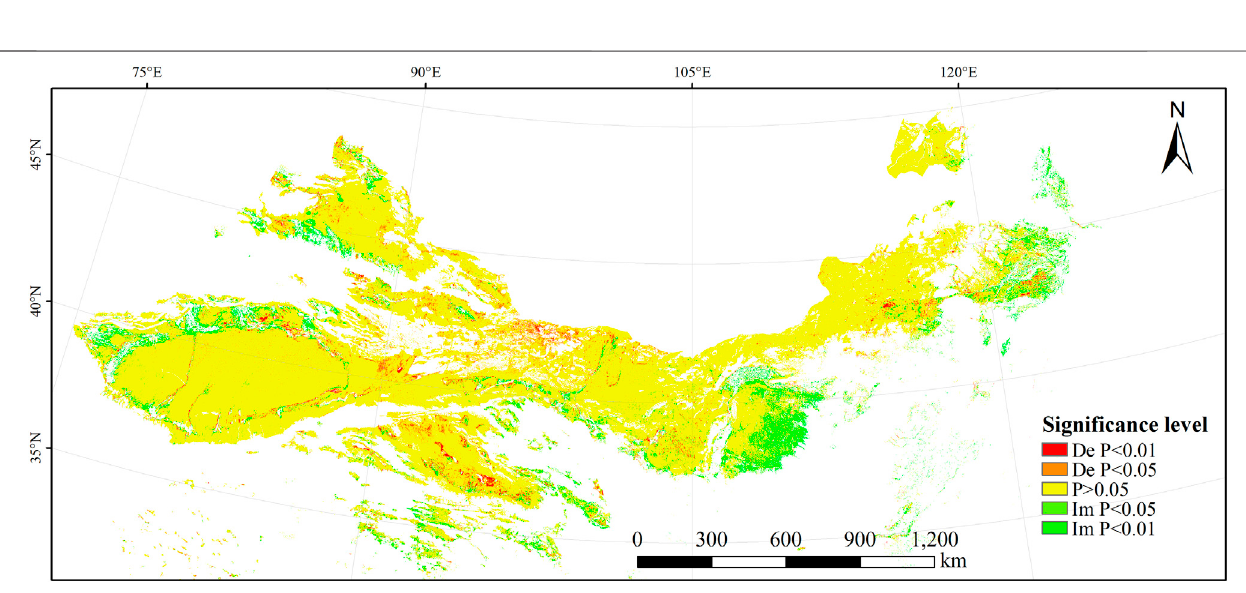
Frontiers in Environmental Science |